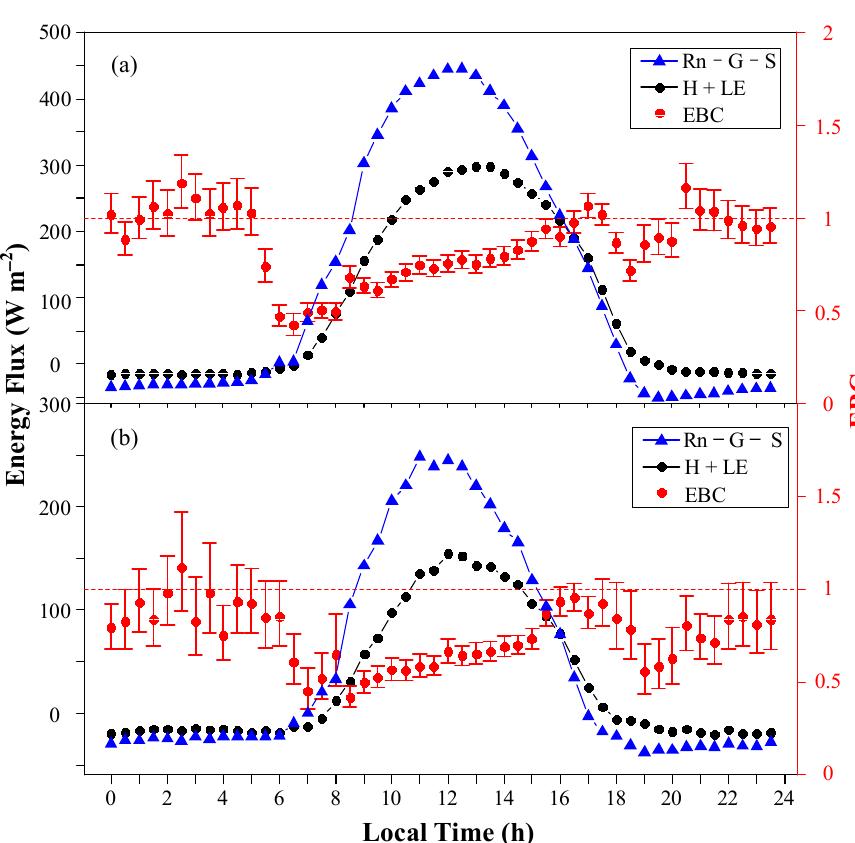
Figure 8. Diurnal variations of (left axis) available energy (net radiation (Rn) − shallow soil heat flux (G) − canopy heat storage (S)) and the sum of turbulent fluxes (sensible heat flux (H) + latent heat flux (LE)) for the 30-min averaged measurements, along with (right axis) energy balance closure (EBC) values during the ( a ) growing season and ( b ) dormant season. Red dots indicate the slope of the relationship between available energy and turbulent fluxes, and error bars represent the 95% confidence interval of the slopes from standard major axis regression (SMA).